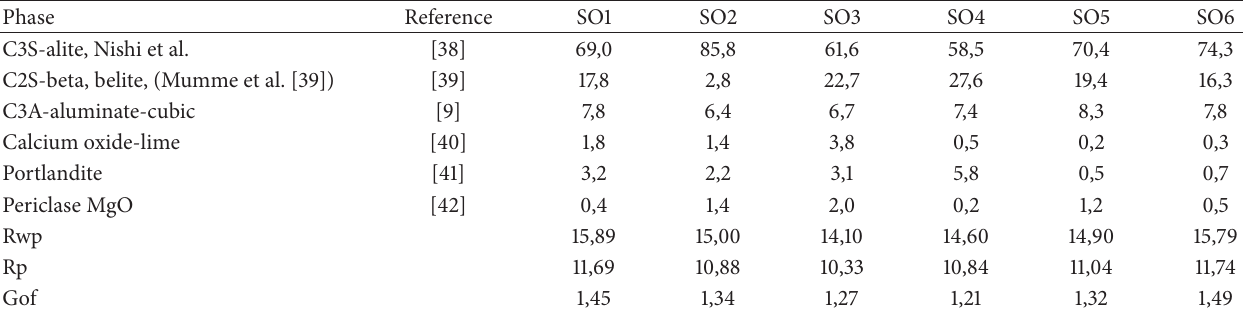
Table 3: Result of Rietveld refinements of the X-ray data. Angular domain: 2 𝜃 Cu =